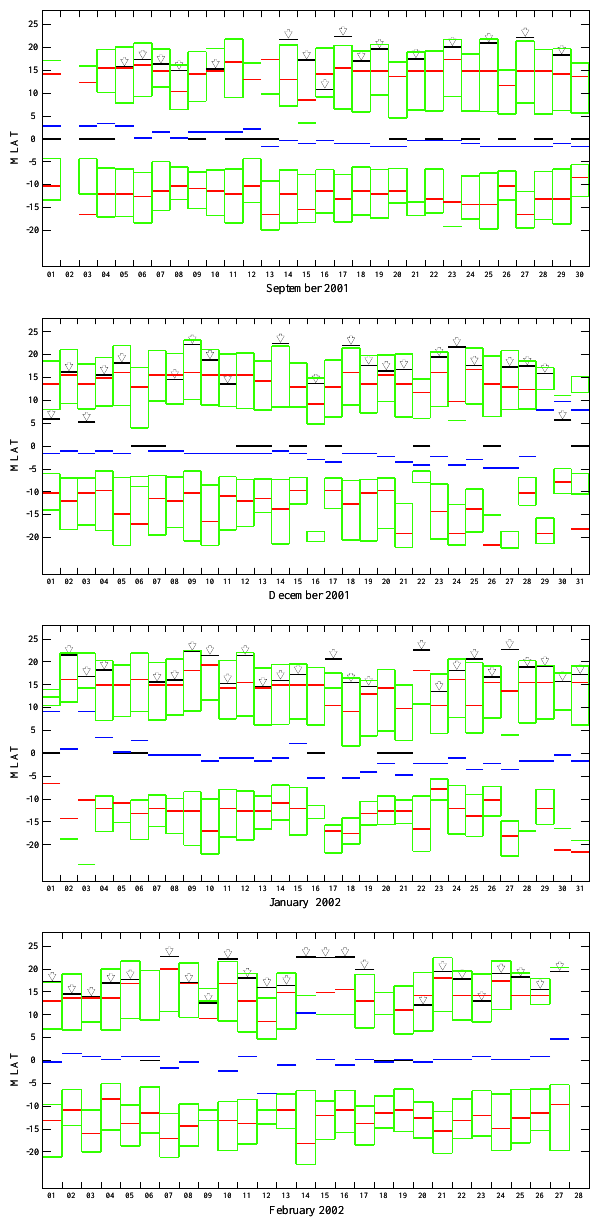
Figure 8. Fig. 8. Latitudinal distribution of the location of the anomaly for the months of September, December, January and February. The blue trace near 0 ◦ magnetic latitude indicates the location of the trough. The red lines are used to point out the locations of the anomaly crests. The green lines indicate the extension where the crests di- minish 50%. The short black lines and the arrows seen near the northern boundary of the northern crest indicate the maximum lat- itude of GPS scintillations. Note that only in a few cases does the maximum latitude of scintillations extend beyond the limits of the